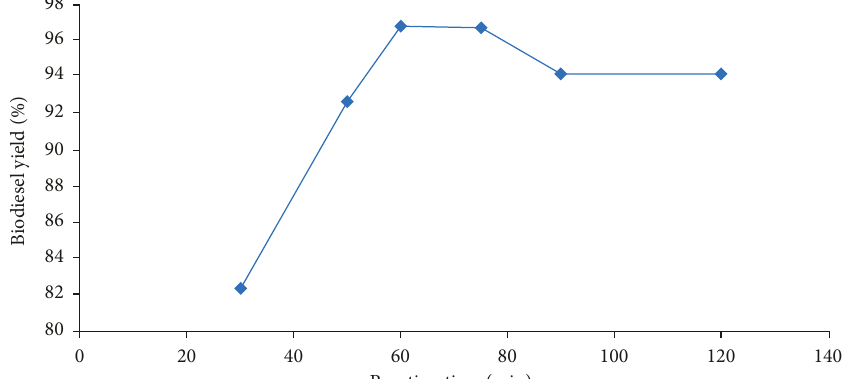
Figure 6: Effect of reaction time on the FAME yield (methanol/oil molar ratio 8:1; catalyst amount 6 wt.%; reaction temperature 60 ° C).